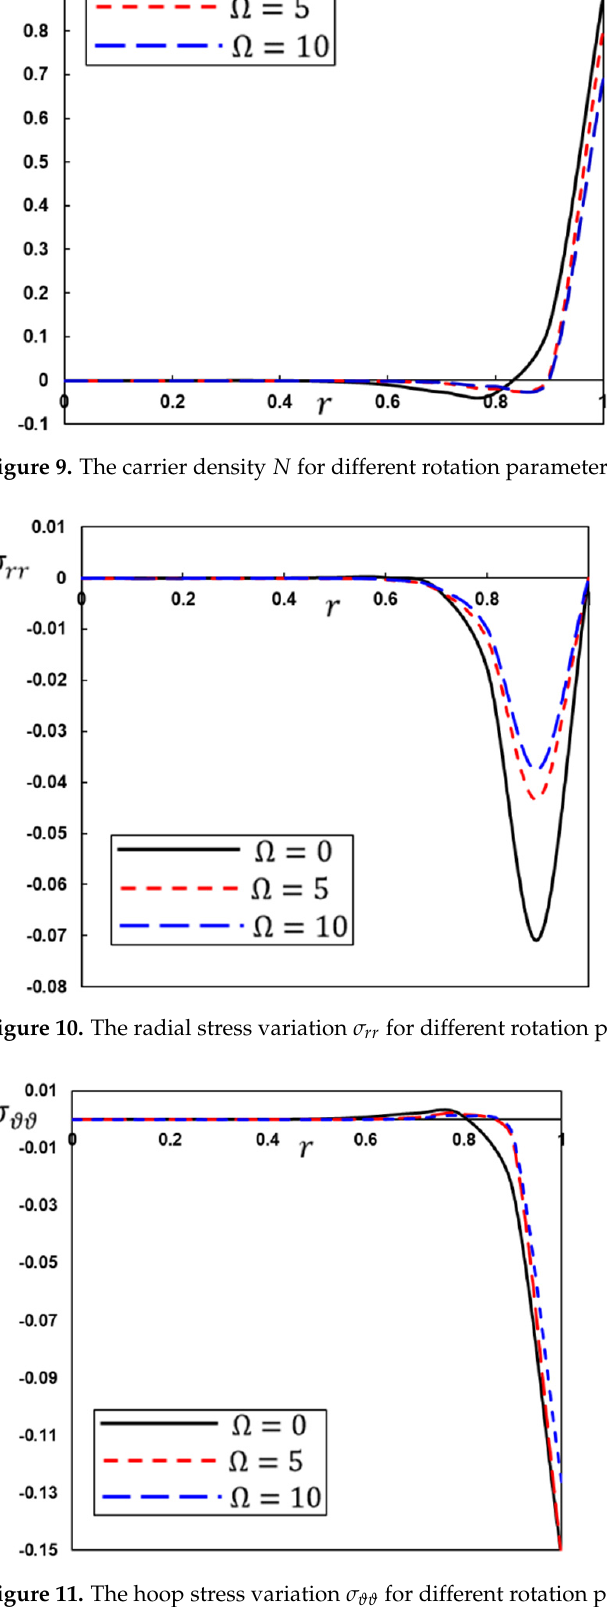
for different rotation parameter Ω . (cid:3107)(cid:3107)